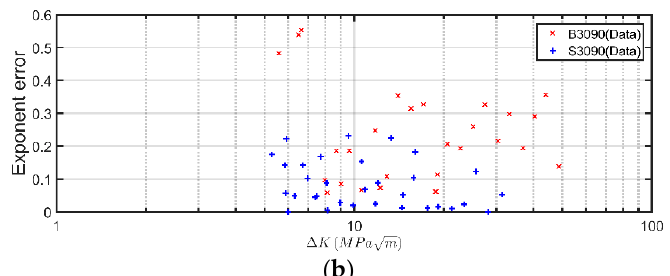
Figure 4. ( a ) Measured, from [37], and computed crack growth curves in the perpendicular (B3090) and parallel (S3090) directions of SLM-manufactured specimens; ( b ) Exponent error of the fitted curves as computed using Equation (4).